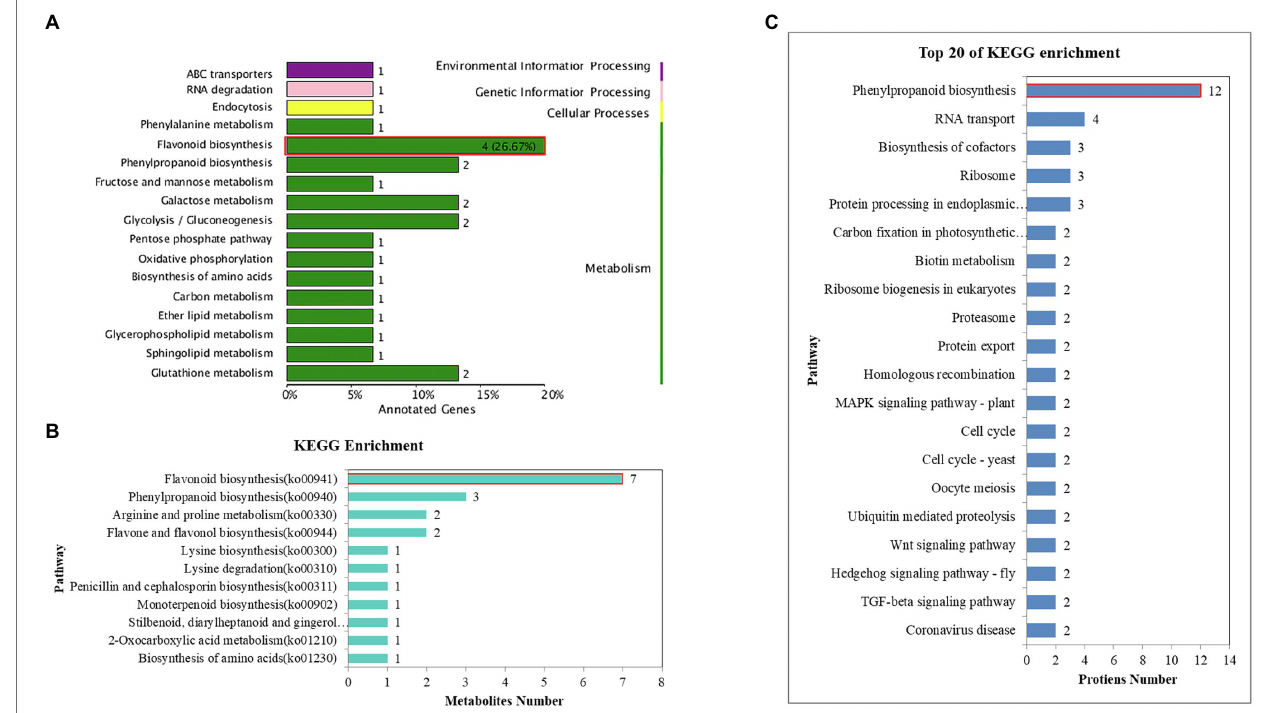
FIGURE 3 | KEGG annotation and enrichment of the common DEGs, DAMs, and DEPs. (A) KEGG enrichment of the common DEGs. (B) KEGG annotation and enrichment of the common DAMs. (C) KEGG annotation and enrichment of the common